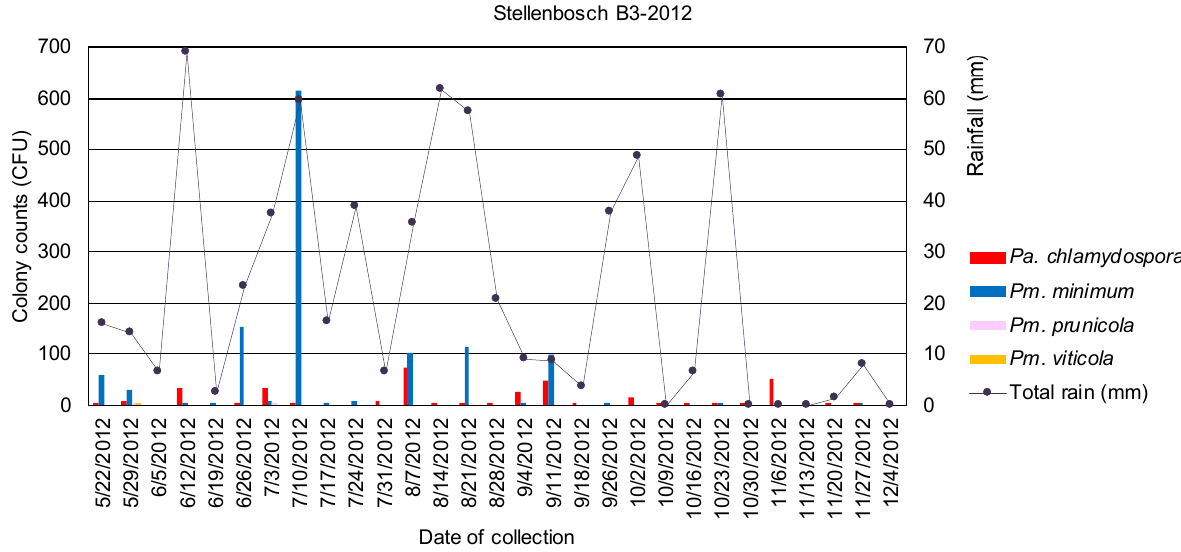
Figure 5. Phaeomoniella and Phaeoacremonium spp. cfu cultured from five vaseline coated microscope slides affixed to the cordons on each of five vines in vineyard Stellenbosch B3, Western Cape province in 2012. The slides were replaced weekly. Each bar represents the total number of cfu cultured on three Petri dishes. Not clear on the graph, Pm. prunicola detection dates are 29/05 and 03/07 and Pm. viticola is